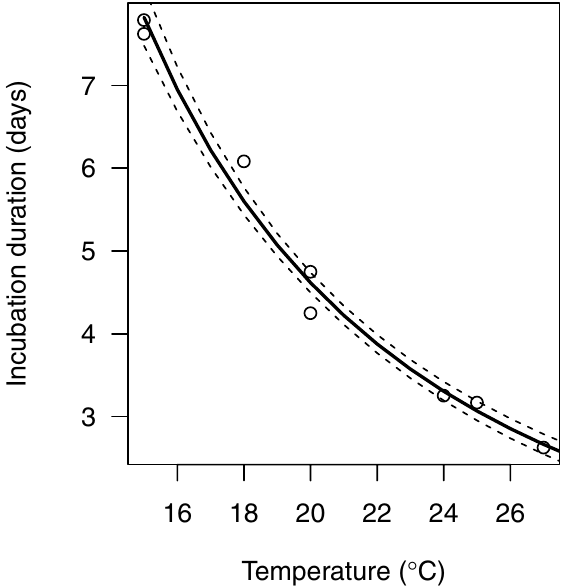
Fig. 2. Incubation duration with respect to temperature. Open circles refer to the experimental data, the solid line represents the power re- gression and the dashed lines indicate the 95% confidence